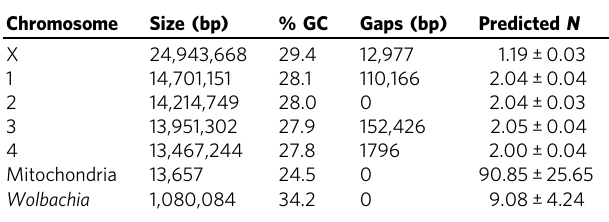
Table 1 Chromosome